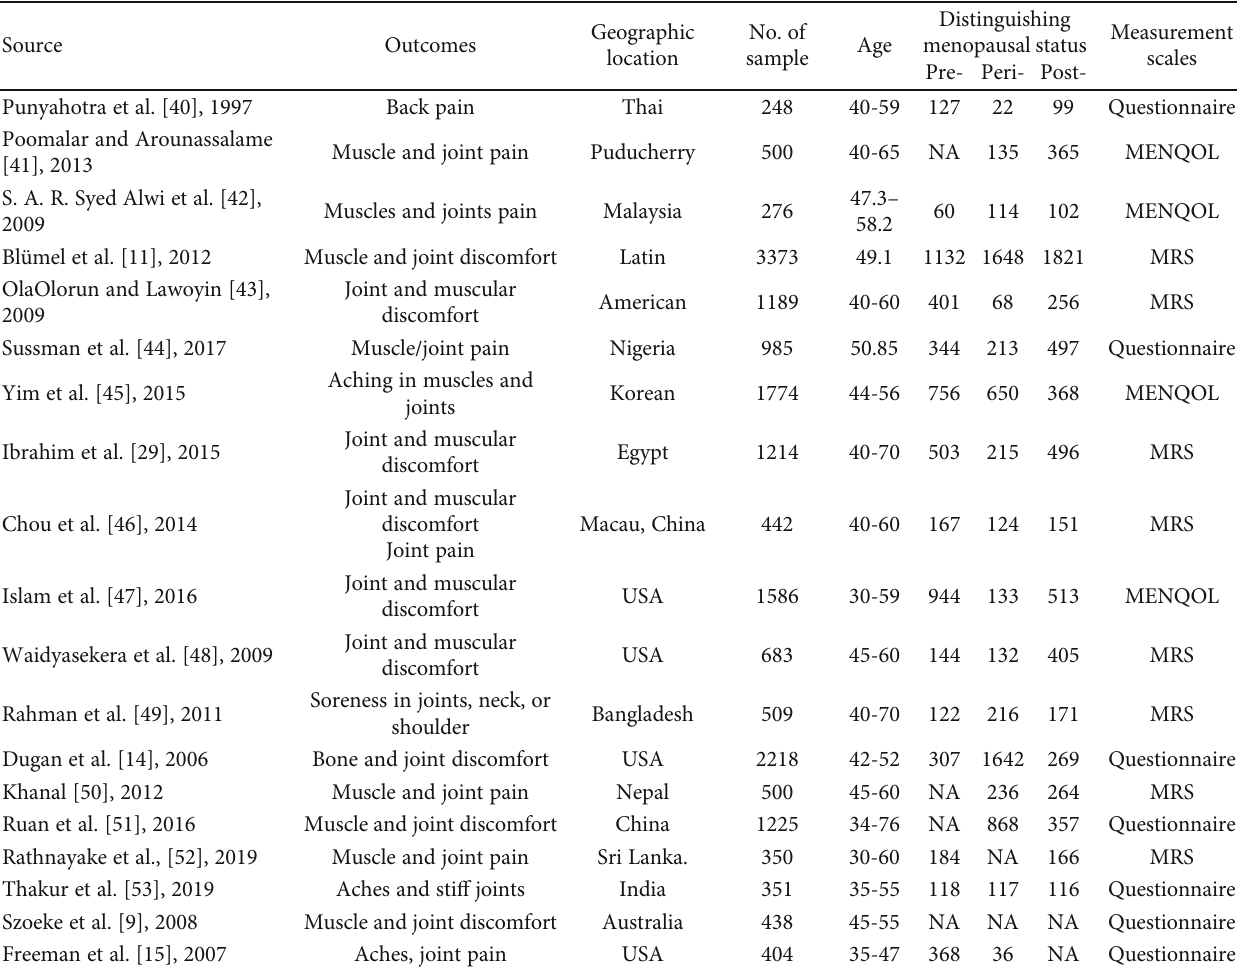
Table 1: Summary of demographic characteristics of the included